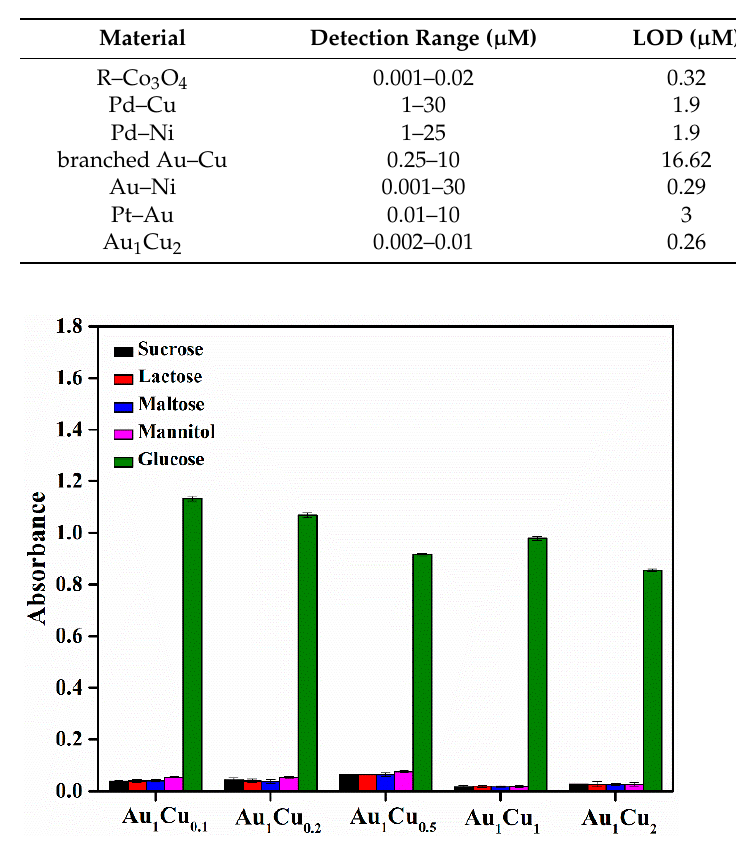
Figure 9. Selectivity analysis of glucose detection using Au–Cu alloy nanoparticles as peroxidase mimetics. The concentration of glucose and other substances was 10 mM.